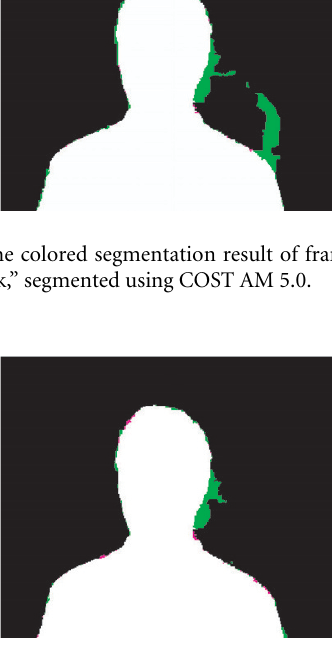
Figure 16: The colored segmentation result of frame 20 from the sequence “Erik,” segmented using COST AM